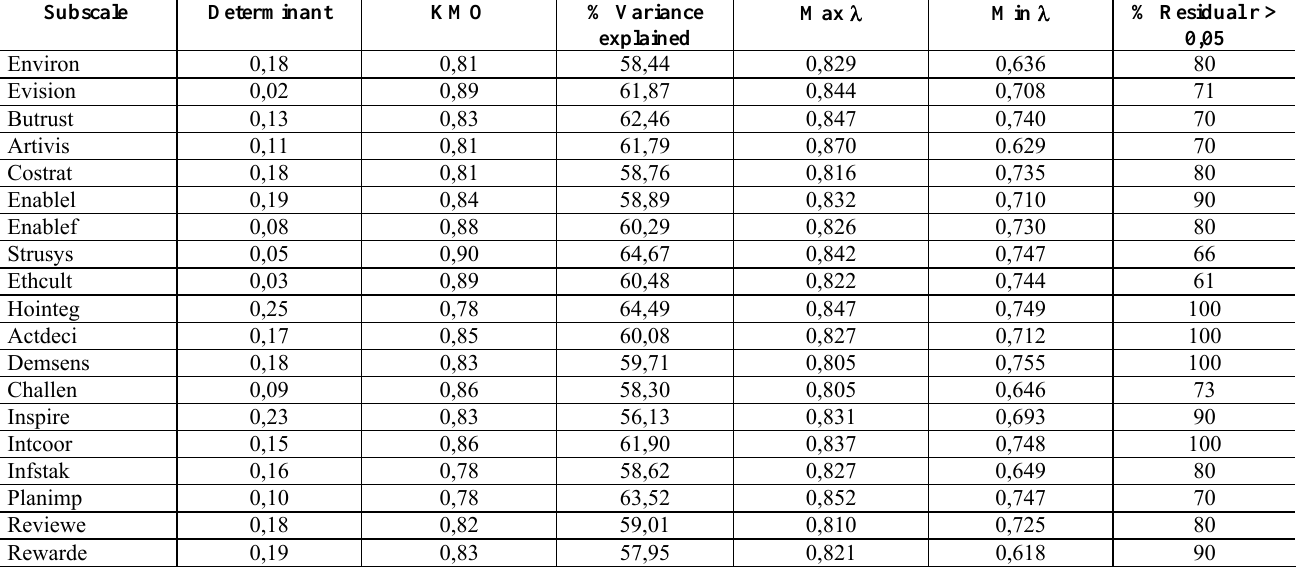
Table 7: Principle component analyses of ELI sub-scale measures Subscale